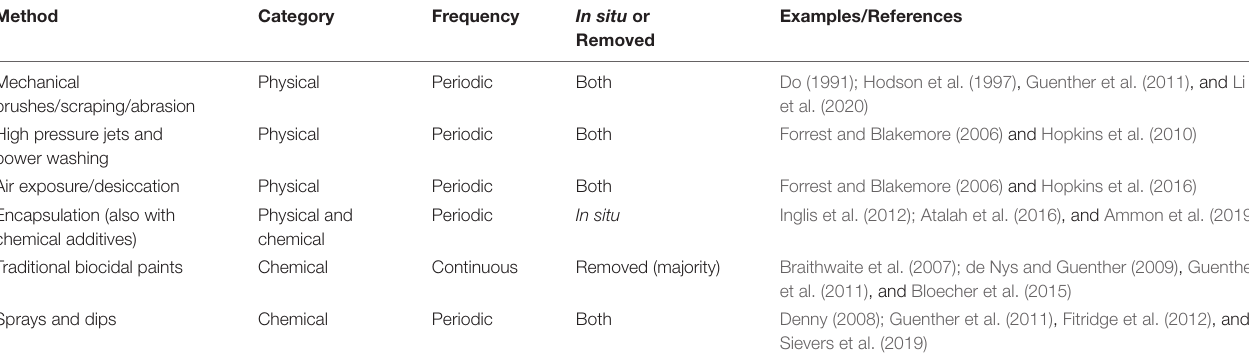
TABLE 1 | Existing approaches to managing biofouling on static submerged marine